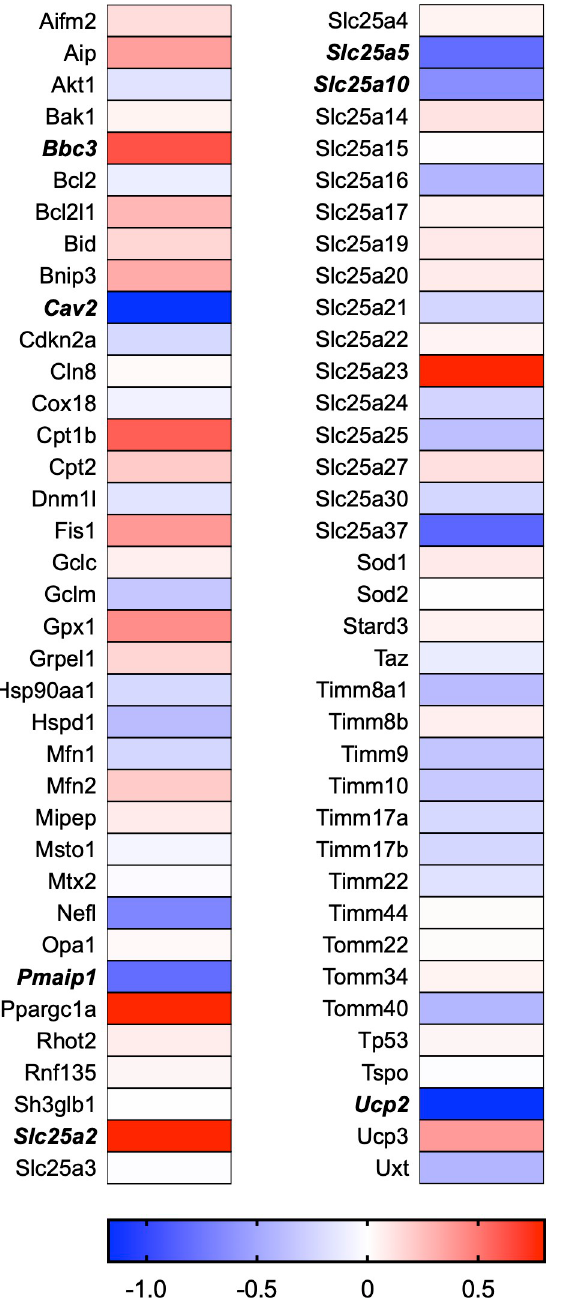
Fig 18. Mitochondria heat map. Bold text indicates significantly altered gene